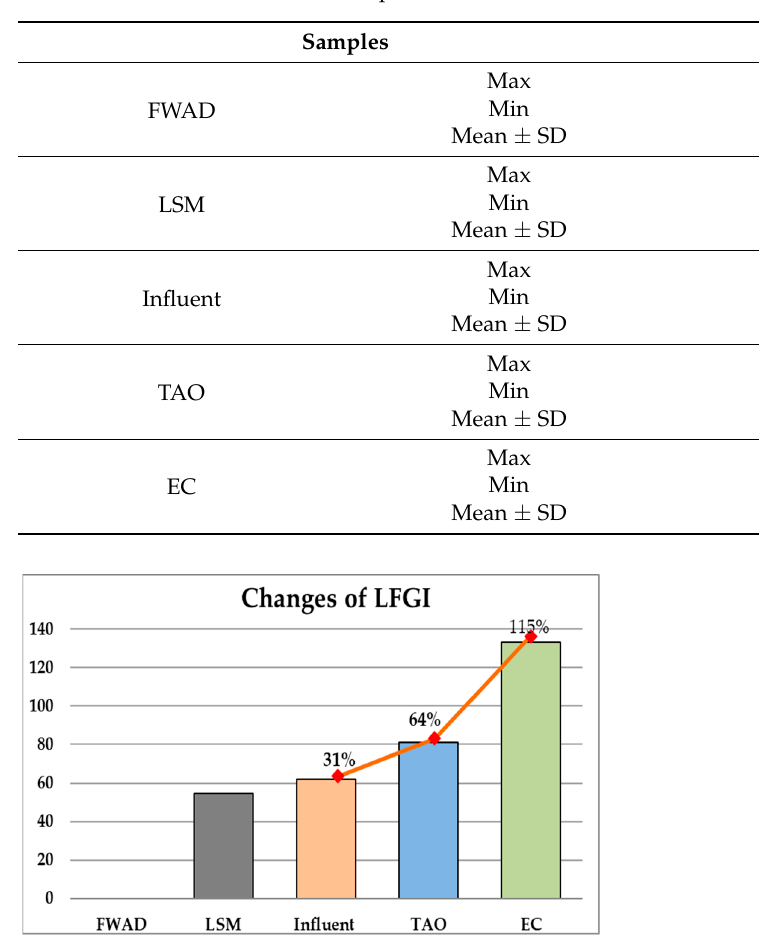
Table 5. Seed GI for the manure samples before and after TAO and EC treatment.